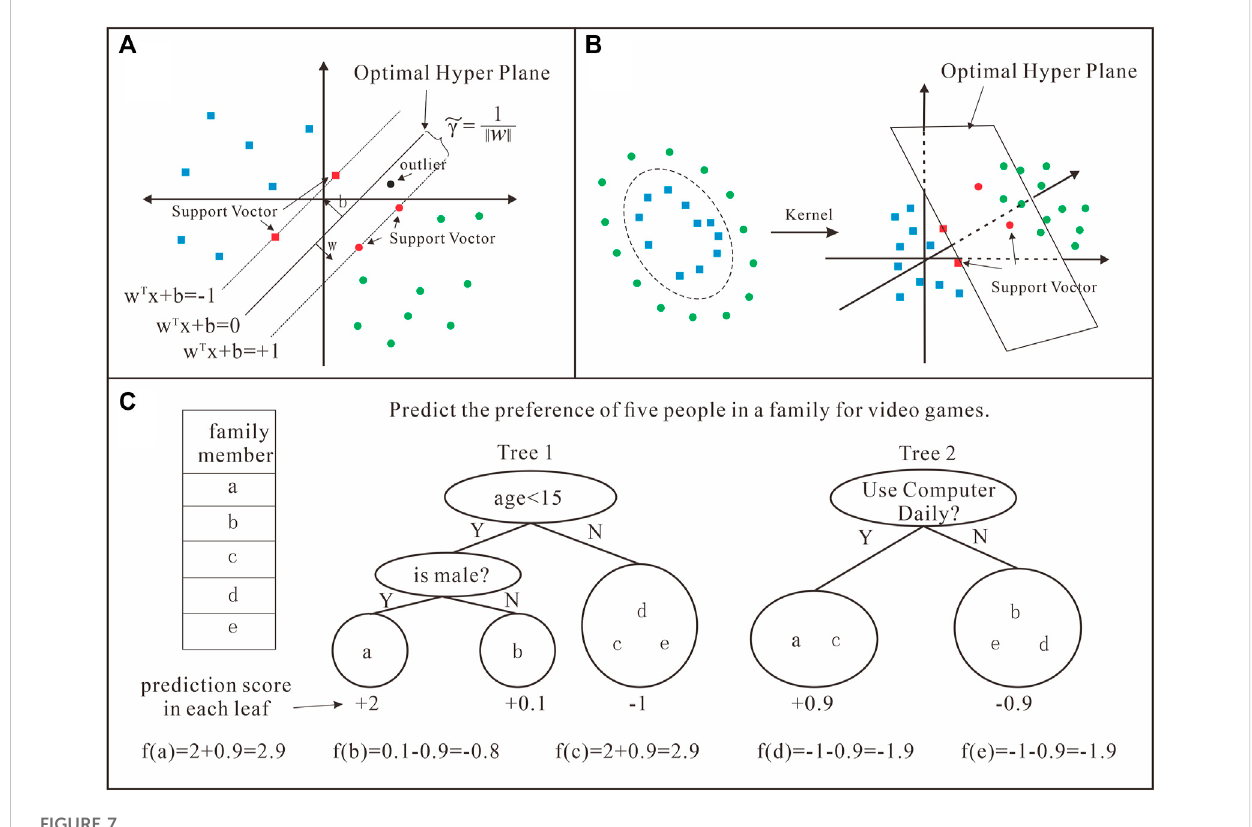
FIGURE 7 Principle sketch map of support vector machine (SVM); two-dimensional linear classi fi cation (A) ; two-dimensional non-linear classi fi cation (B) (quote from Harrington (2012) and modi fi ed locally) and extreme gradient boosting (XGBoost); the fi nal prediction for a given example is the sum of the predictions from each tree (C) (quote from Chen and Guestrin